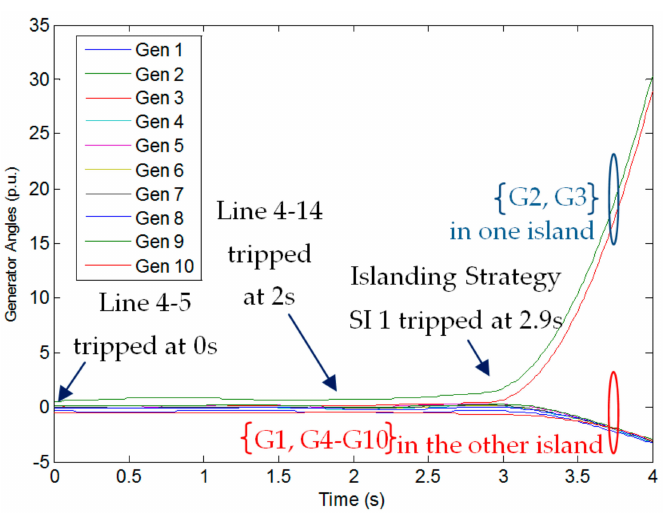
Figure 7. Islanding strategy IS1 applied at critical islanding time (CIT) 2.9 s.